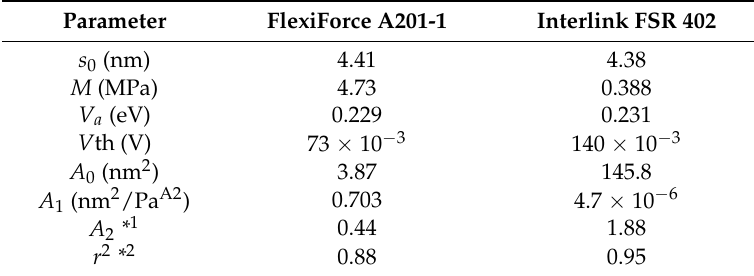
Table 3. Parameters obtained from the surface fit for the piecewise Equations